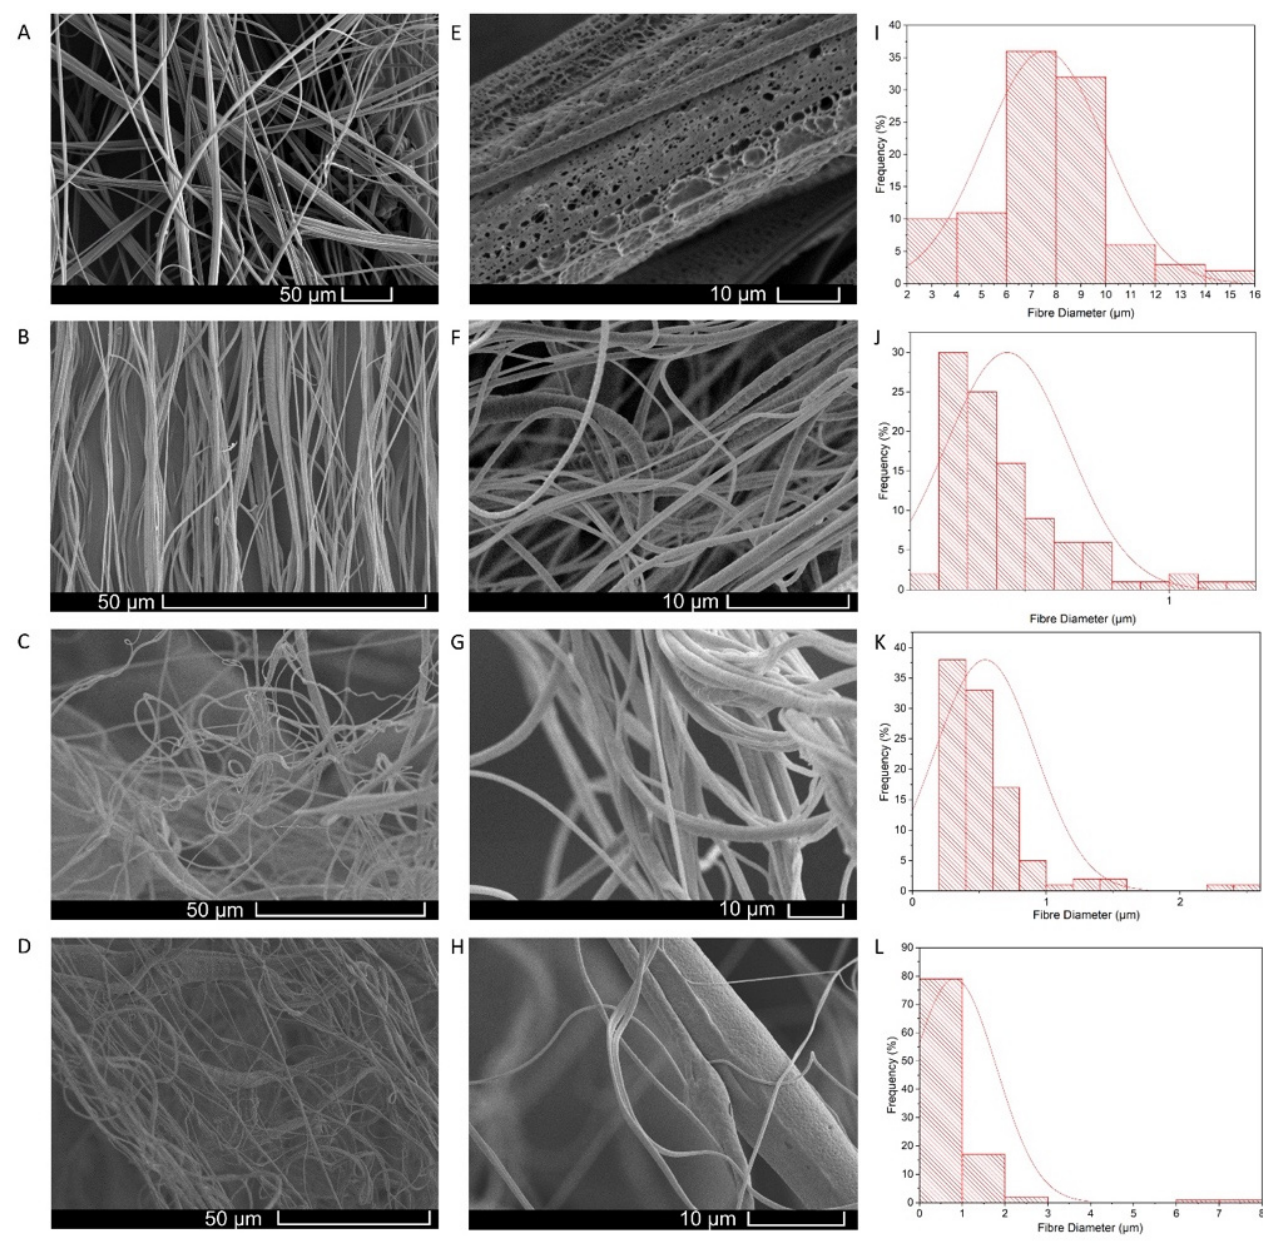
Figure 5. Scanning Electron Microscope Image of Fibres Produced. ( A ) Virgin PCL fibres, ( B ) 10% honey-composite fibres, ( C ) 20% honey-composite fibres, ( D ) 30% honey-composite fibres. High magnification images of ( E ) virgin PCL fibres, ( F ) 10% honey-composite fibres, ( G ) 20% honey-composite fibres, ( H ) 30% honey-composite fibres, along with corresponding fibre diameter distribution histograms ( I – L ).